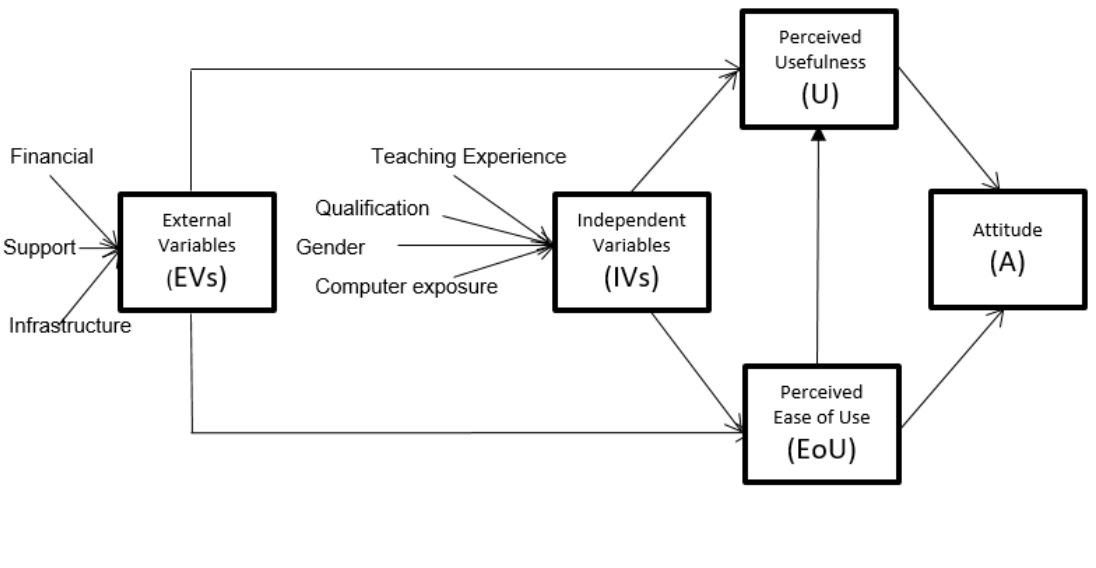
Figure 1. A conceptual framework of the study. Adapted from Davis, Bagozzi & Warshaw (1989). The TAM is an information systems theory that predicts how the user comes to accept and use technology. The model (Figure 1) consists of four constructs: external variables (EV), perceived usefulness (U), perceived ease of use (EoU), and attitude (A) toward e-learning. The